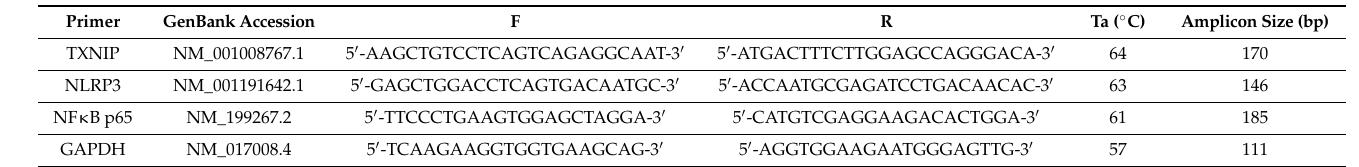
Table 3. Primer sequences for